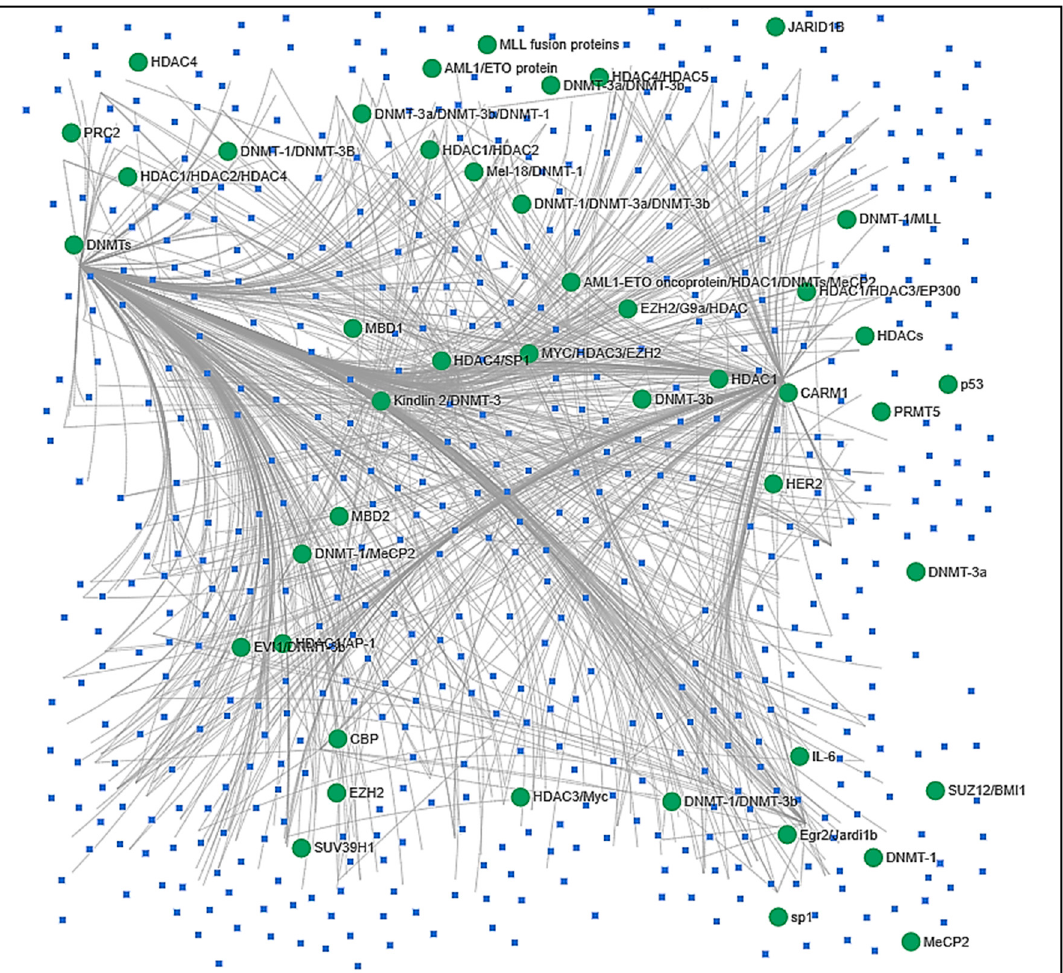
Figure 2. A miRNA-epigenetic network analysis. The diagram represents a network analysis outcome conducted in miRNet suite among 555 miRNAs with 48 epigenetic modifiers hosted by the tool itself. Among those modifiers, DNA methyltransferases (DNMTs) and histone deacetylases (HDACs) showed a strong connection with miRNAs and other modifiers. The enlisted 48 modifiers used were as follows: AML1-ETO oncoprotein / HDAC1 / DNMTs / MeCP2, AML1 / ETO protein, CARM1, CBP,